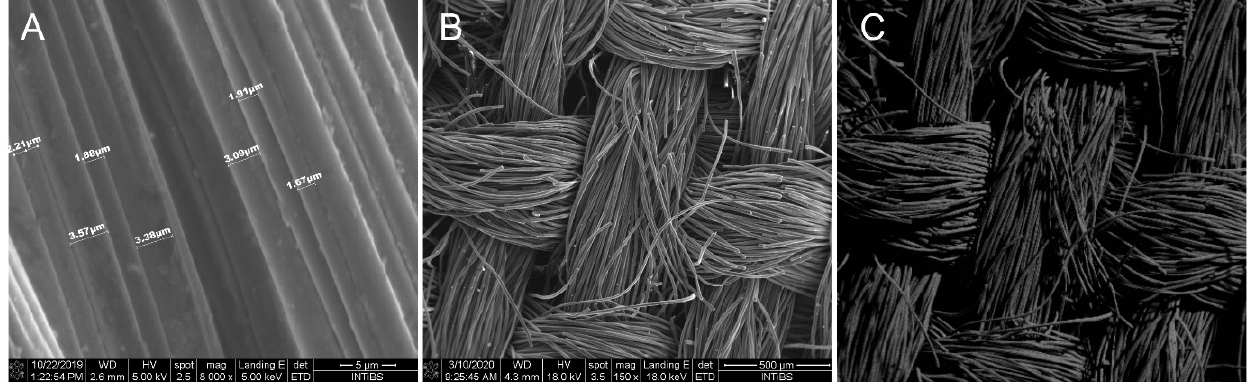
Figure 7. Microstructure SEM—magnification 8000× ( A ) and 150× ( B ) of ACC cloth (part of FSM) and elemental analysis (EDS) of carbon distribution ( C ) .